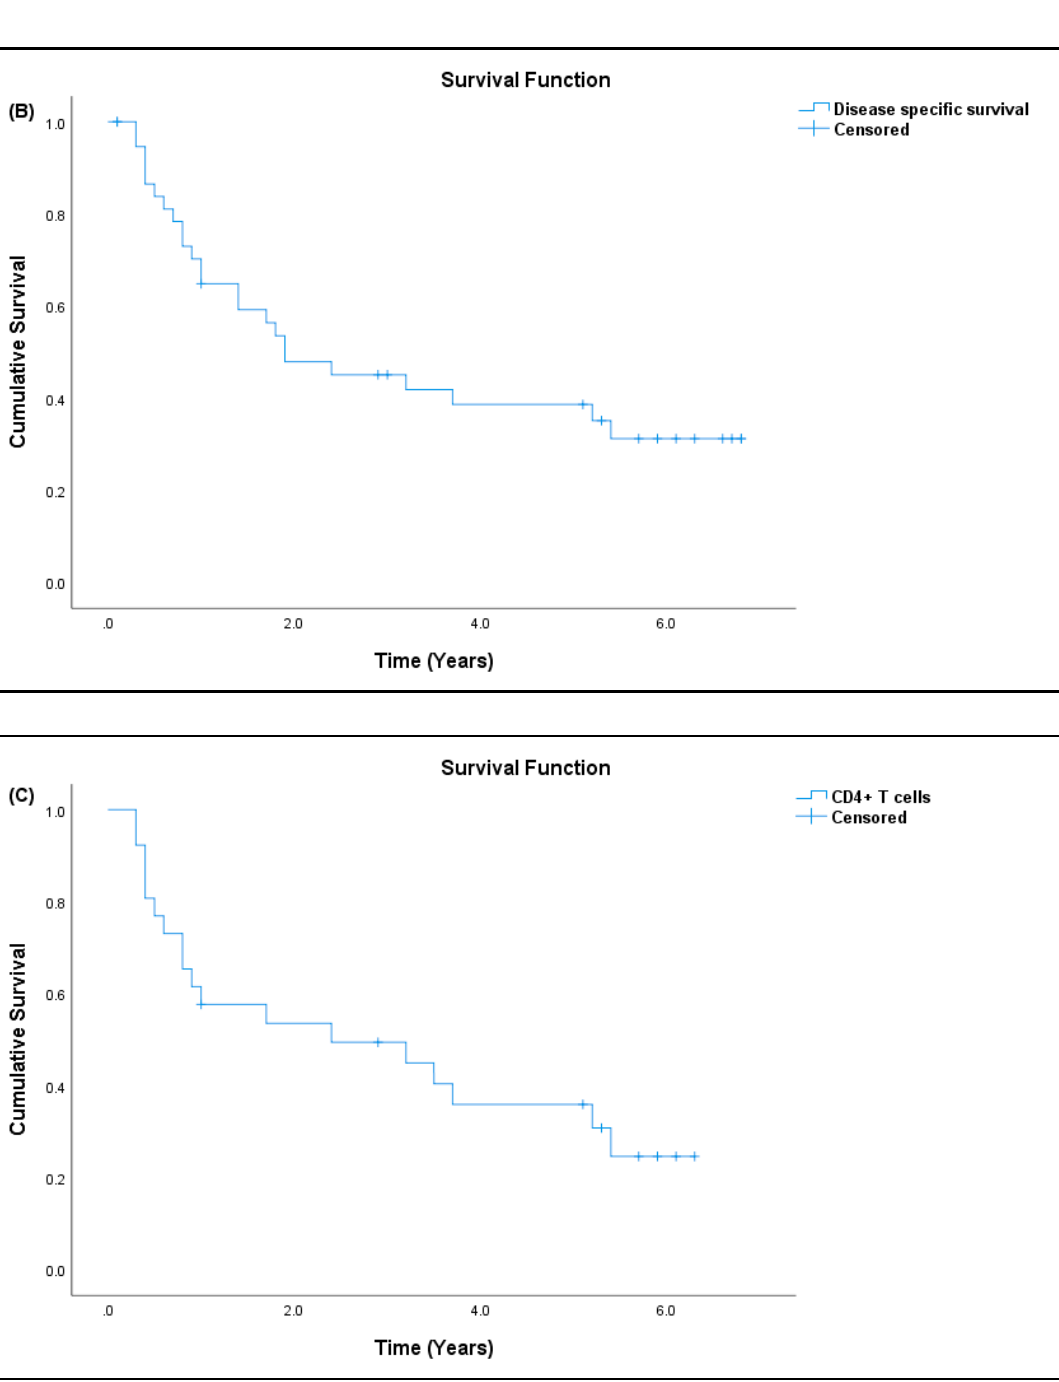
Figure 5. Kaplan–Meier curve for overall survival. ( A ) All sarcoma patients, ( B ) disease-specific sarcoma patients, and ( C ) patients tested for CD4 + T-cell/lymphocyte percentage.